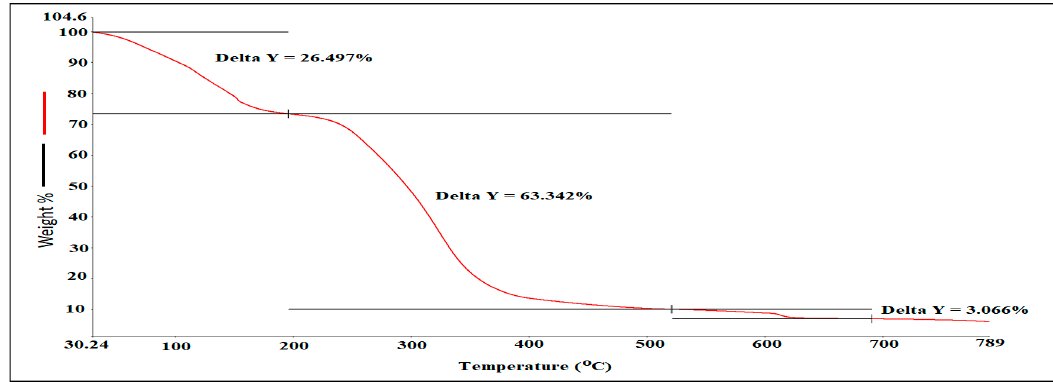
Figure 4. TG curve in hyphenated TG ‐ IR. Table 4. Mass loss vs. Temperature.